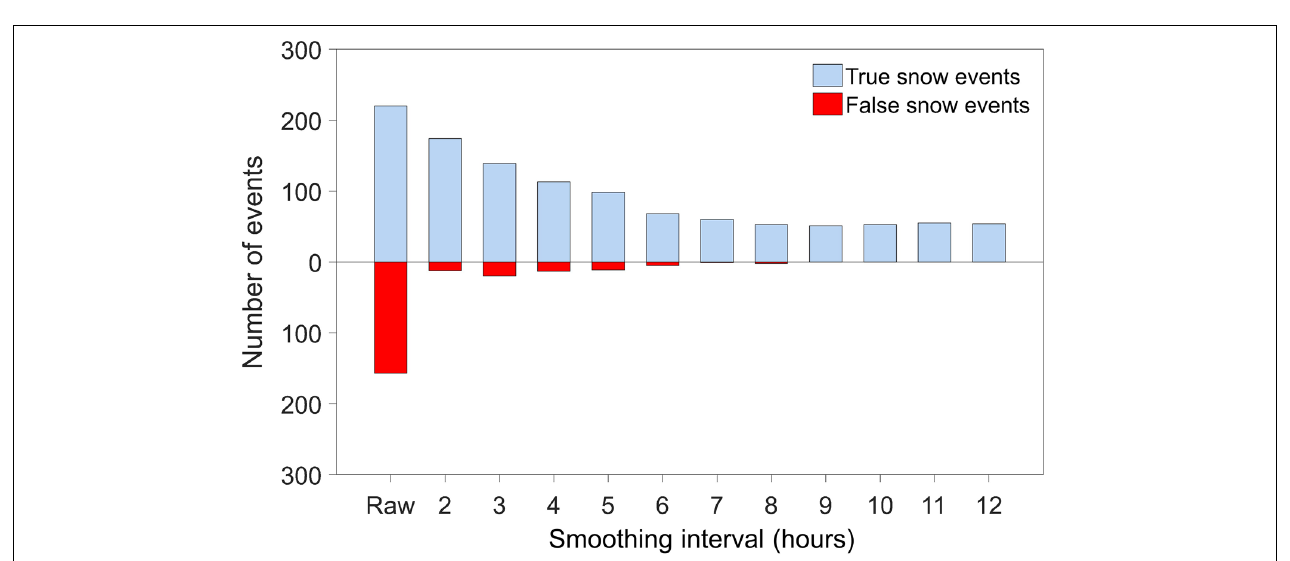
FIGURE 5 | Temporal variation in SWE and snow cover continuity. (a,b) Snow cover classes for SWE and snow depth. Periods where a uniform snowpack is present are highlighted in purple and times when a discontinuous snowpack is present are shown in pink. Instrument uncertainties are displayed as a shaded gray band. Boxplots display the variation in snow pit SWE and depth measured on the 30th April, 2018. (c,d) The magnitude and proportion of SWE values and snow depths that occur while there is discontinuous snow cover. (e,f) Examples of uniform (e) and discontinuous (f) snow cover from time-lapse imagery close to the automatic weather